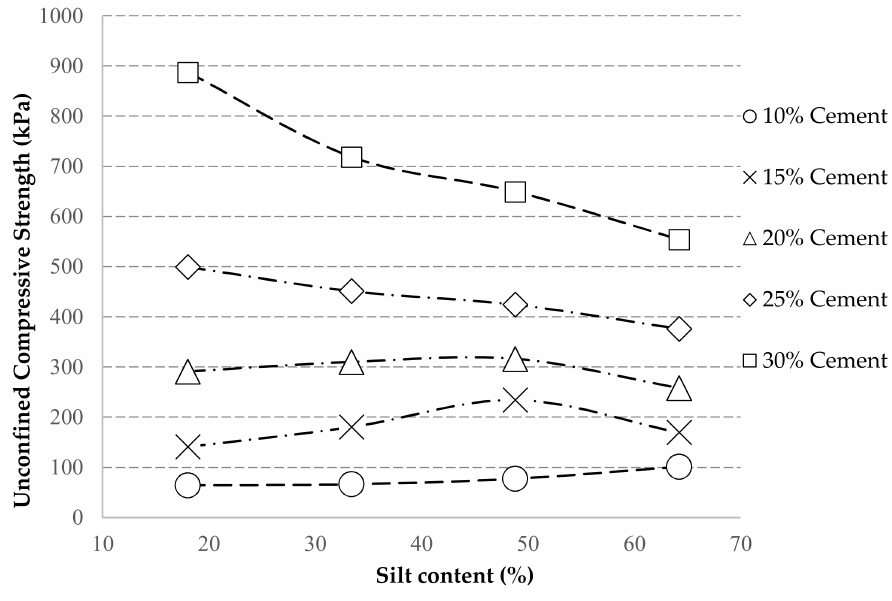
Figure 10. Correlation between Unconfined Compressive Strength (UCS) and silt